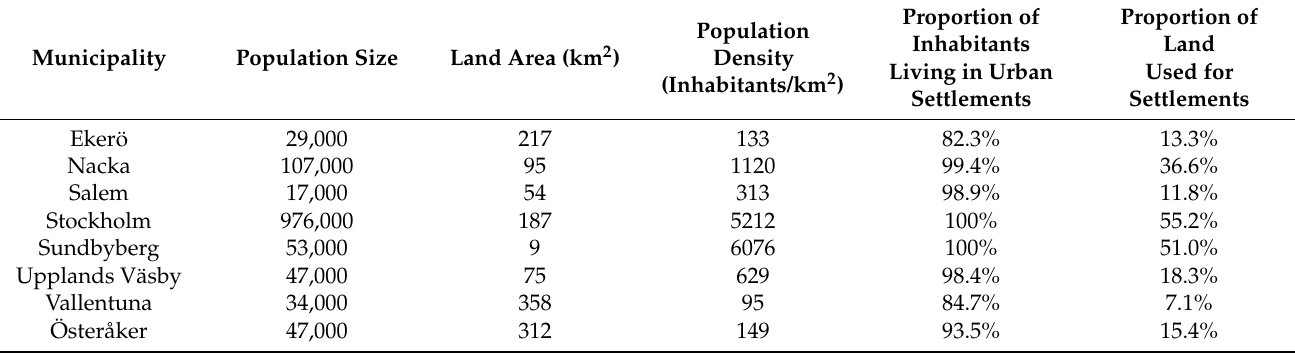
Table 1. Key statistics on selected municipalities